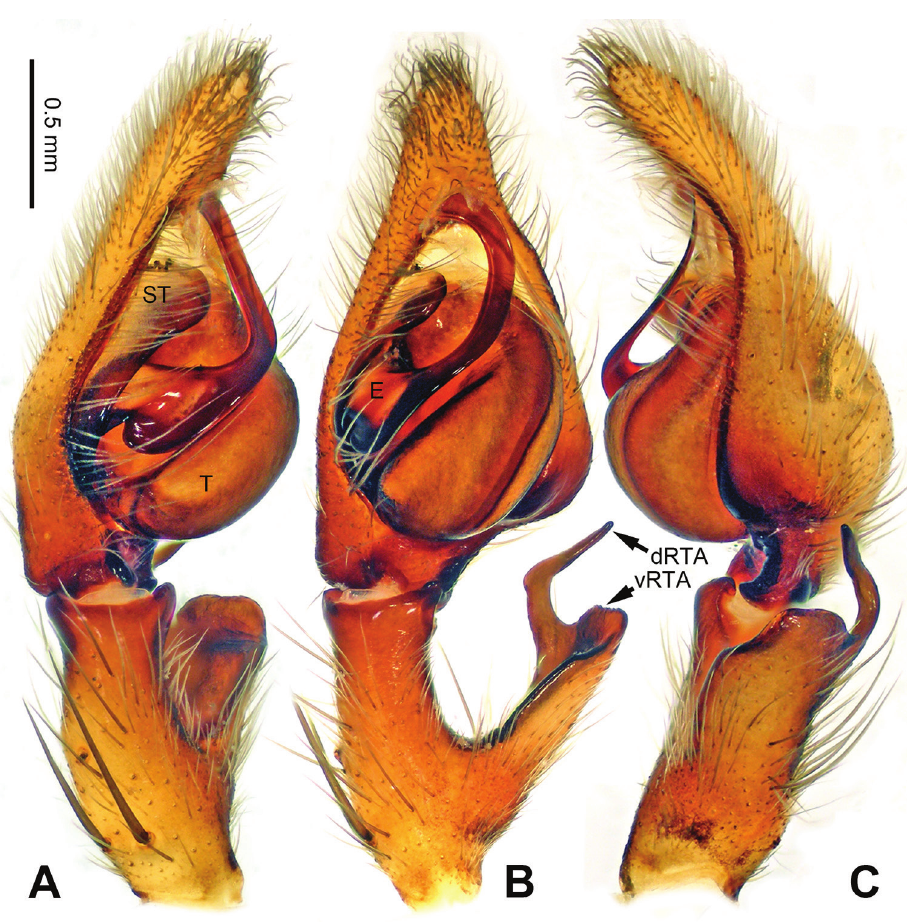
Figure 6. Pseudopoda conaensis Zhao & Li, sp. n., left palp of male holotype. A Prolateral view B Ventral view C Retrolateral view. Scale bar equal for A, B, C